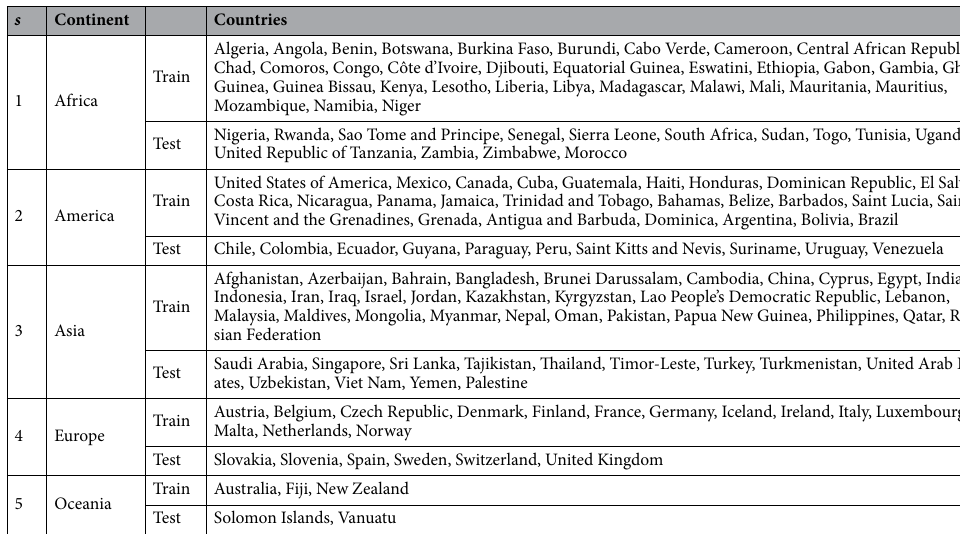
Table 1. Countries included in this study in the training and testing periods.